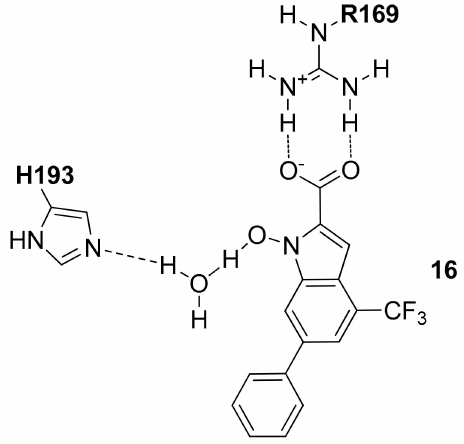
Figure 7. Schematic 2D representation of the 16 – h LDH5 H-bond